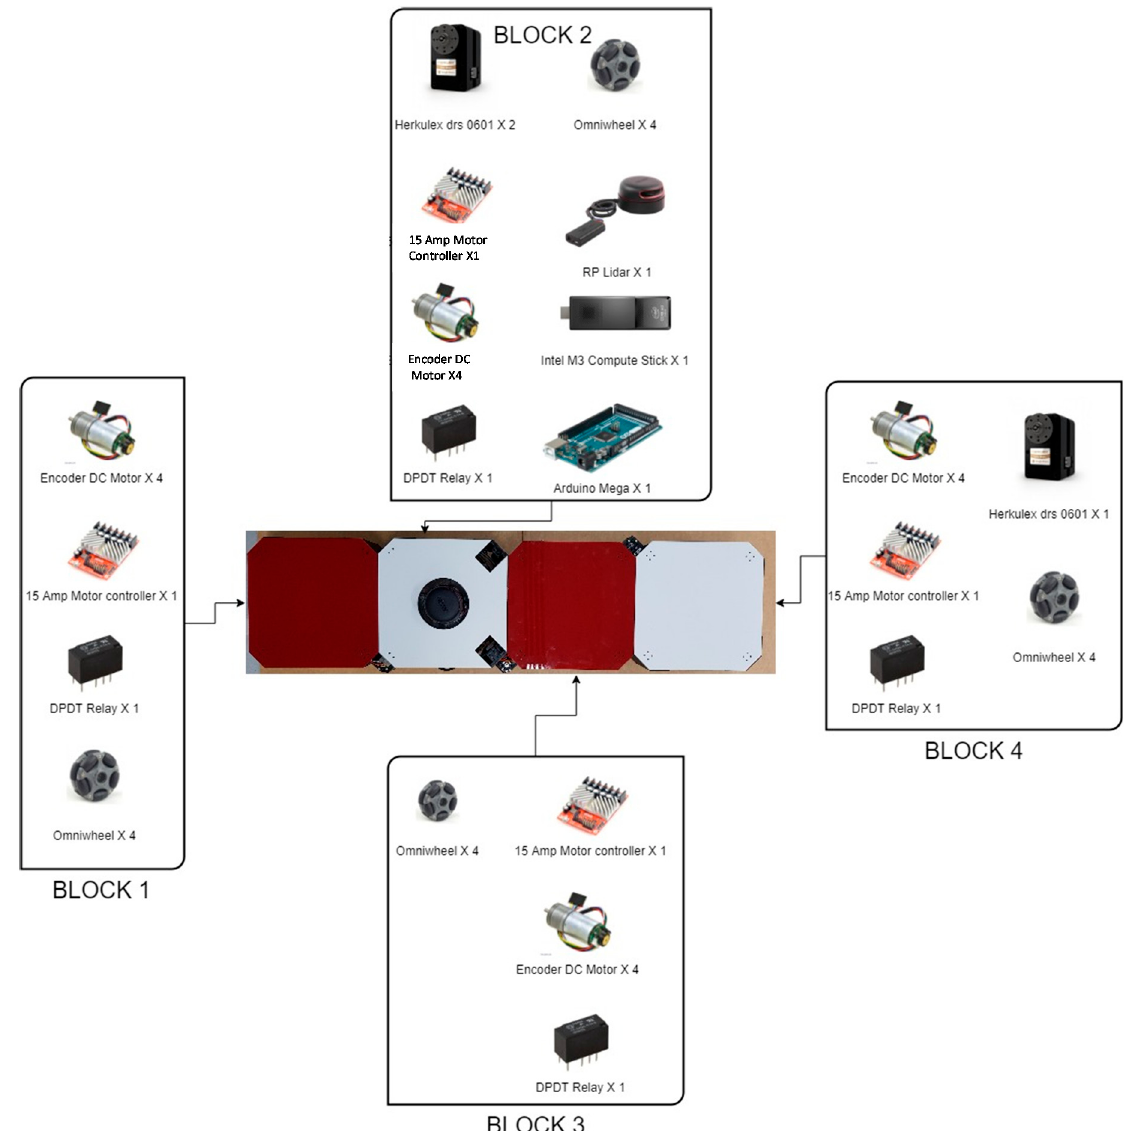
Figure 1. hTetro 5.6_Components List.